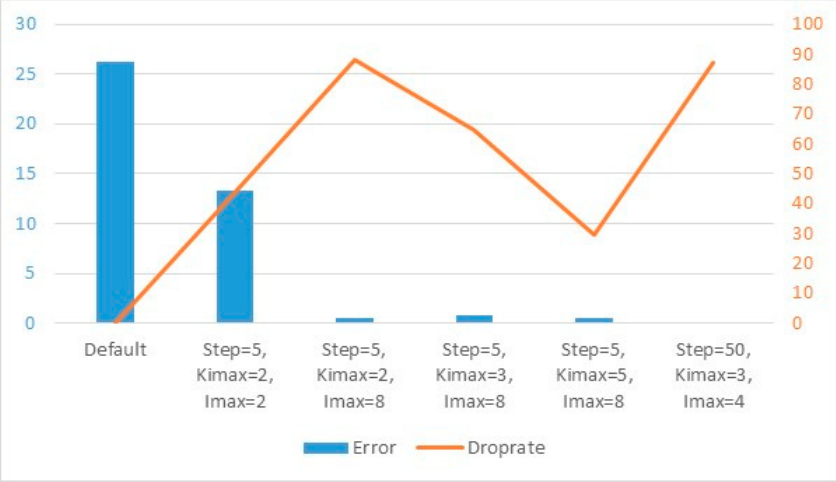
Figure 13. Trickle-based broadcast mechanism test results.